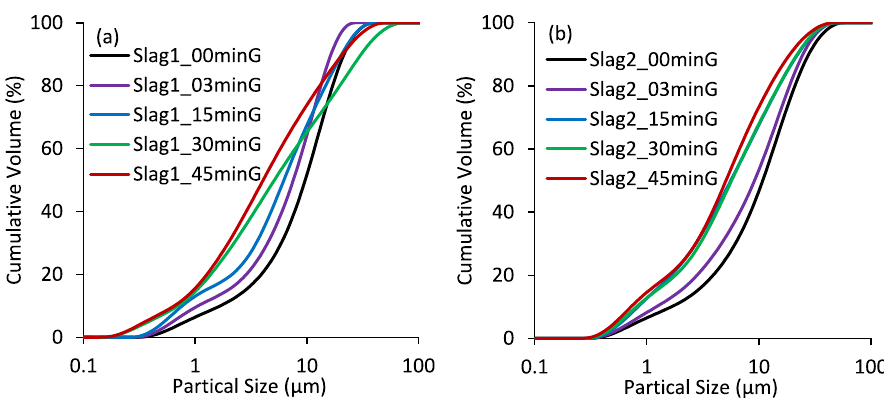
Figure 3. Cumulative particle size distributions by laser diffraction for (a) slag1 and (b)